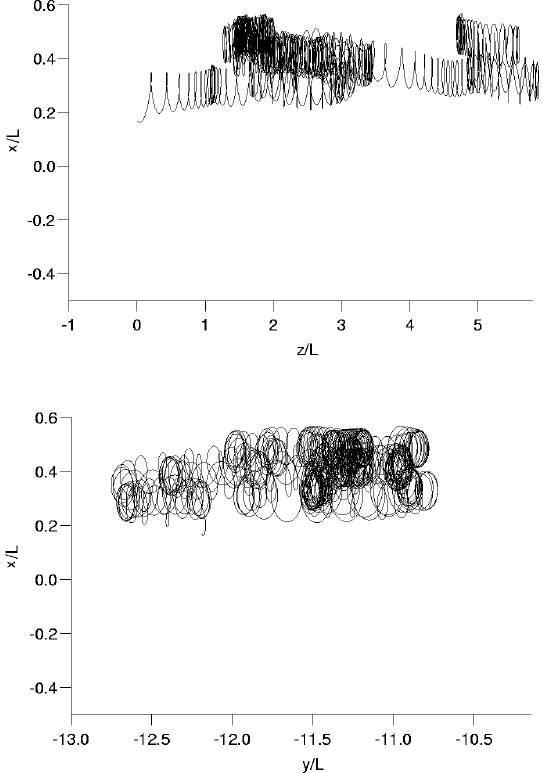
Fig. 4. A sample of an escaping ion